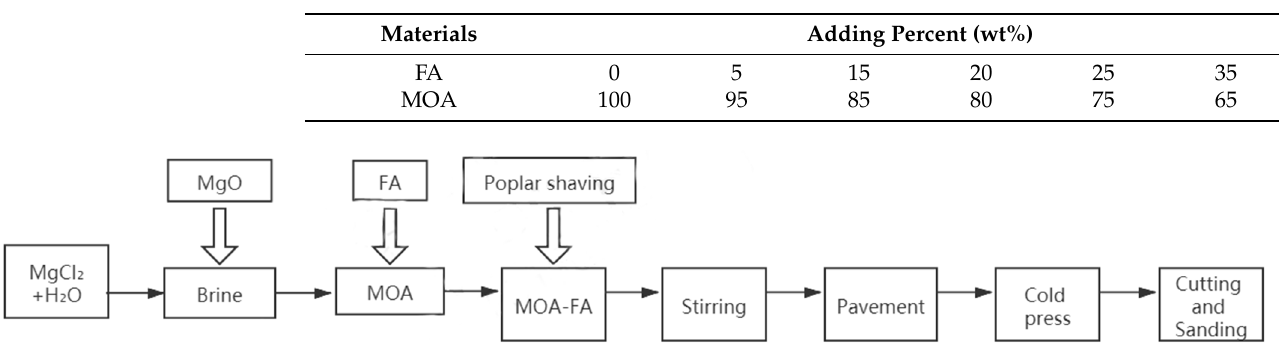
Table 3. Addition percent of FA.